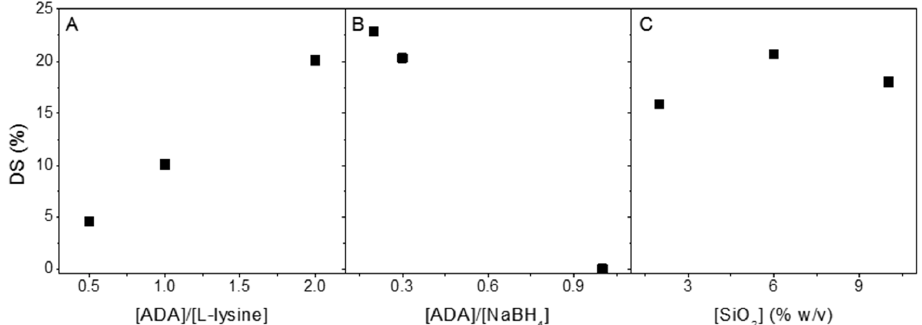
Figure 2. Degree of substitution (mmol %) as a function of the concentration of L -lysine (mmol) using 3 mmol of NaBH 4 and 6% ( w / v ) SiO 2 ( A ), NaBH 4 (mmol) using 1 mmol of ADA and 6% ( w / v ) SiO 2 ( B ), and 2,6, and 10% ( w / v ) SiO 2 using 1 mmol of ADA and 3 mmol of NaBH 4 ( C ). All reactions were conducted at pH 5.8 at room temperature in 10% methanol solutions.